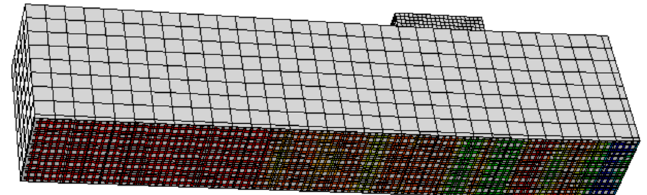
Figure 4. Shear slippage of C-FRM layer in the beam strengthened by an ICCP and C-FRM layer.